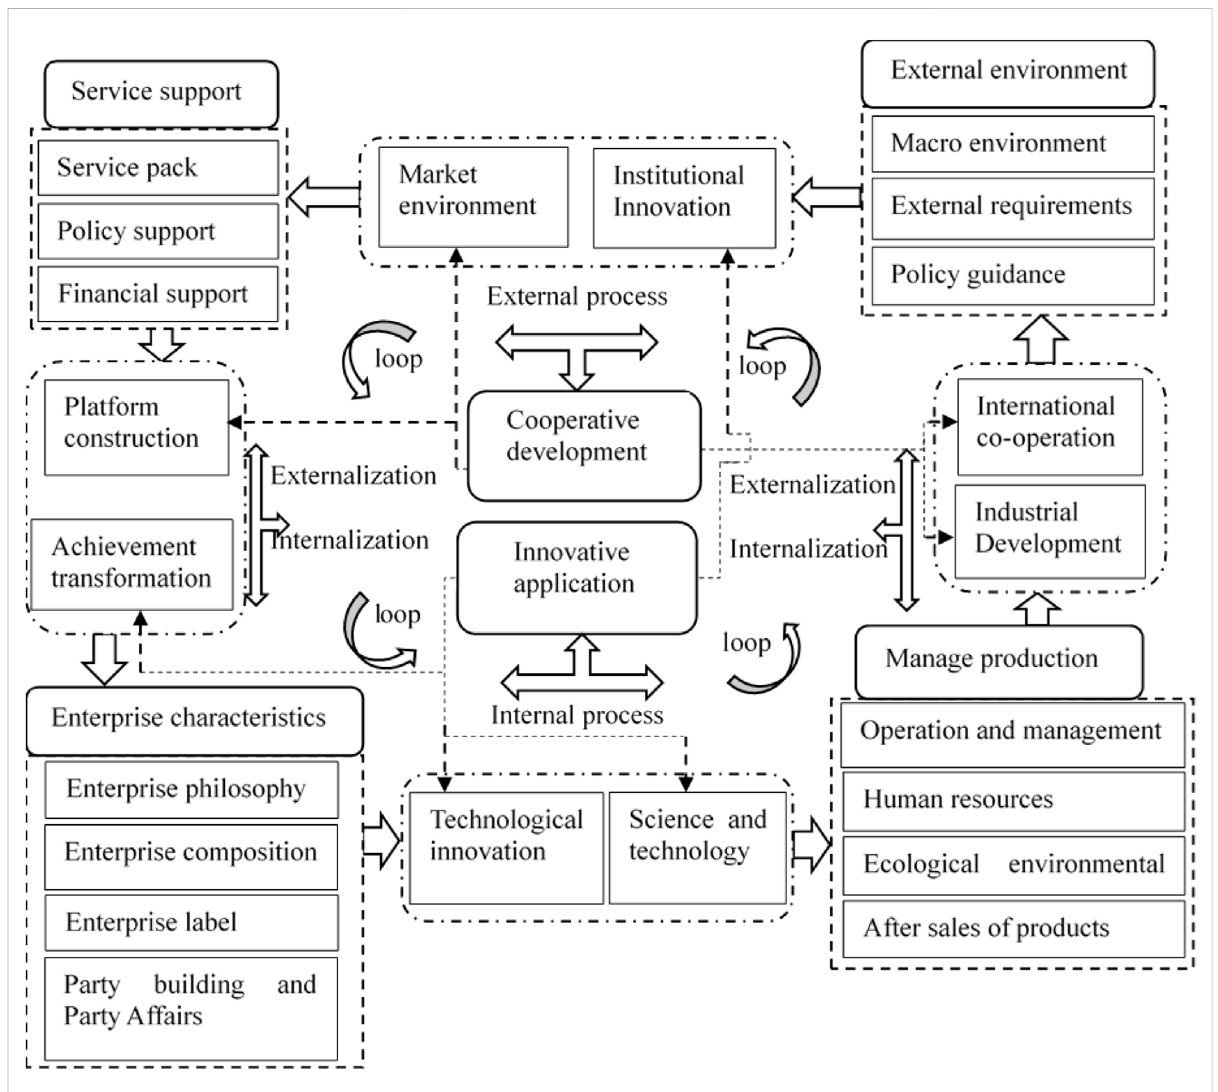
FIGURE 2 Theoretical framework for in fl uencing factors for the high-quality green development of industrial